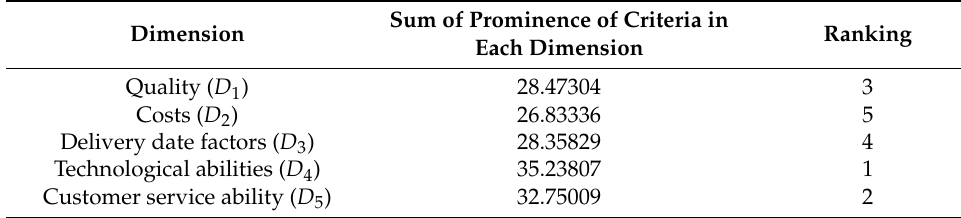
Table 8. Ranking of prominence among dimensions in this research. Sum of Prominence of Criteria Dimension